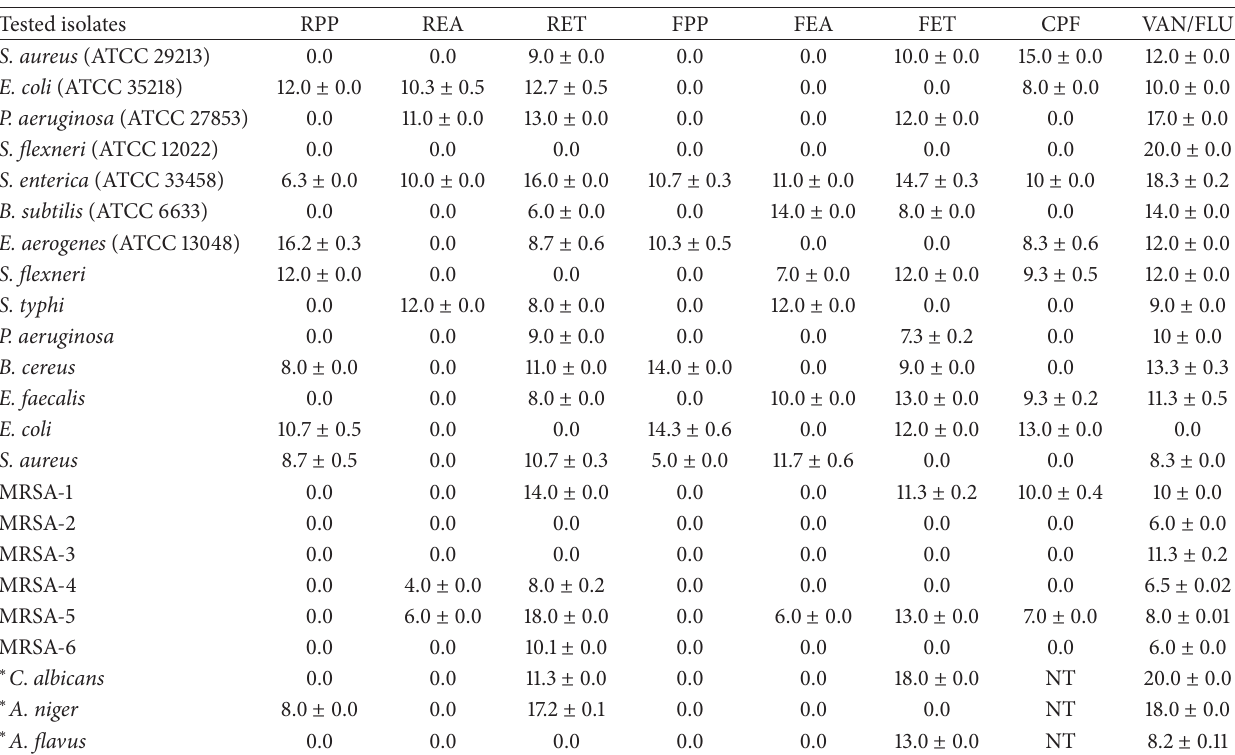
Table 3: Zones of inhibition (mm) of raw and fermented extracts against indicator organisms at 50